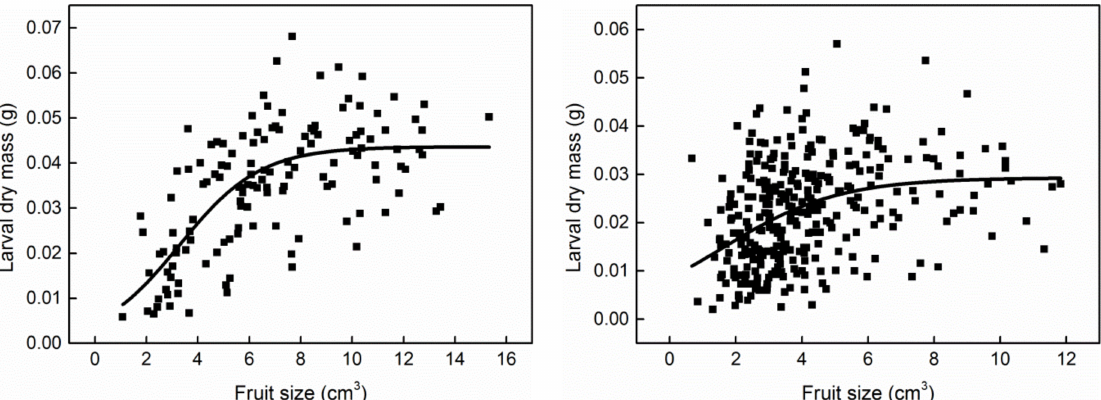
Figure 5. Relationships between larval dry mass (g) and fruit size (cm 3 ) based on logistic model: ( a ) C . oleifera ; ( b ) C . meiocarpa .